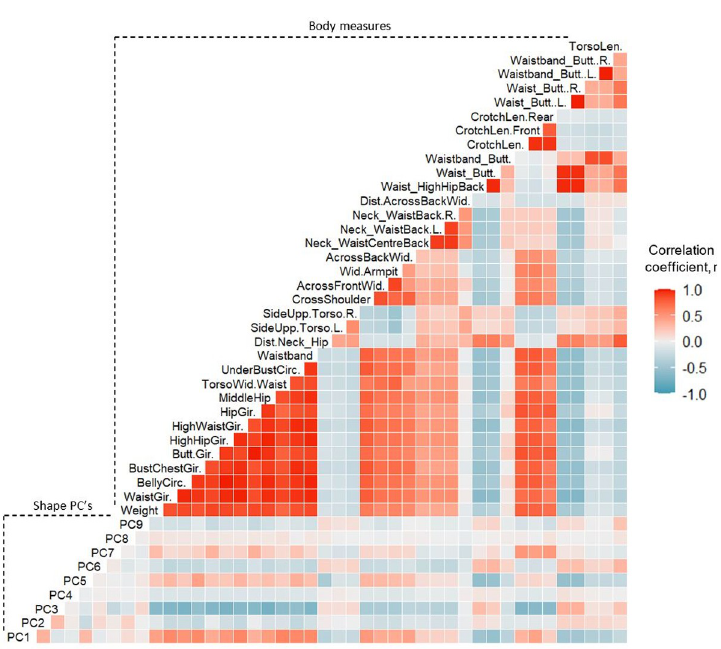
Fig 5. Correlation matrix of female participant measures. Strength of linear relationships between traditional body measures and shape PCs for female participants. Dark red panels indicate a strong positive correlation, dark blue panels indicate a strong negative correlation, lighter panels indicate weak